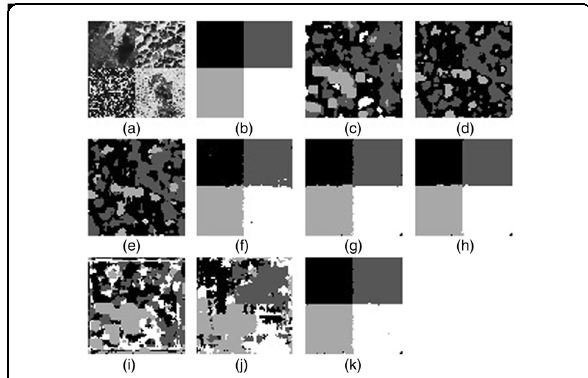
Fig. 25 Segmentation results for a mosaic from Brodatz album without noise. a Original image. b Hand-segmented image. c Gaussian features. d Rayleigh features. e Alpha-stable features. f Gaussian + contourlet features. g Rayleigh + contourlet features. h Alpha-stable + contourlet features. i Fractal dimension. j Fractal + contourlet. k Alpha-stable +